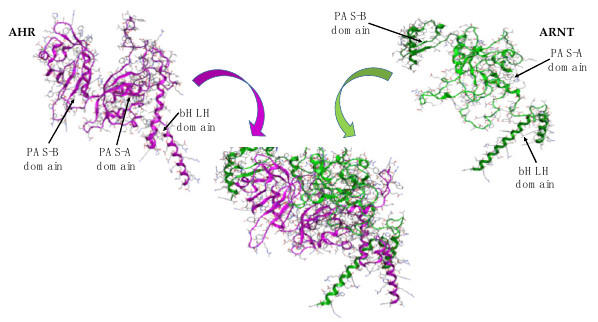
Figure 1. Structural architecture of the interaction of the monomers AHR and ARNT for the formation of the functional heterodimer AHR:ARNT modeled by SwissModel.